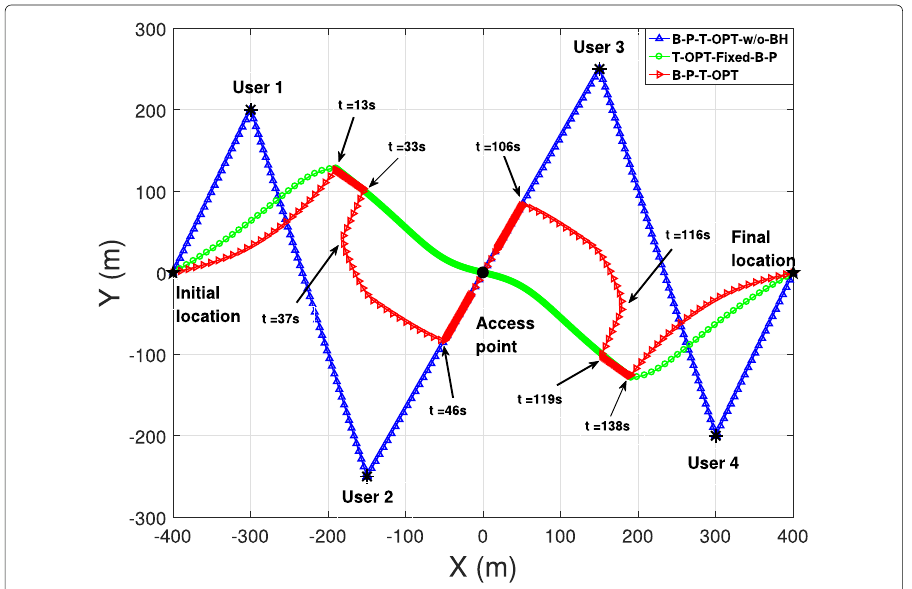
Fig. 3 UAV trajectories obtained by different schemes when T = 150